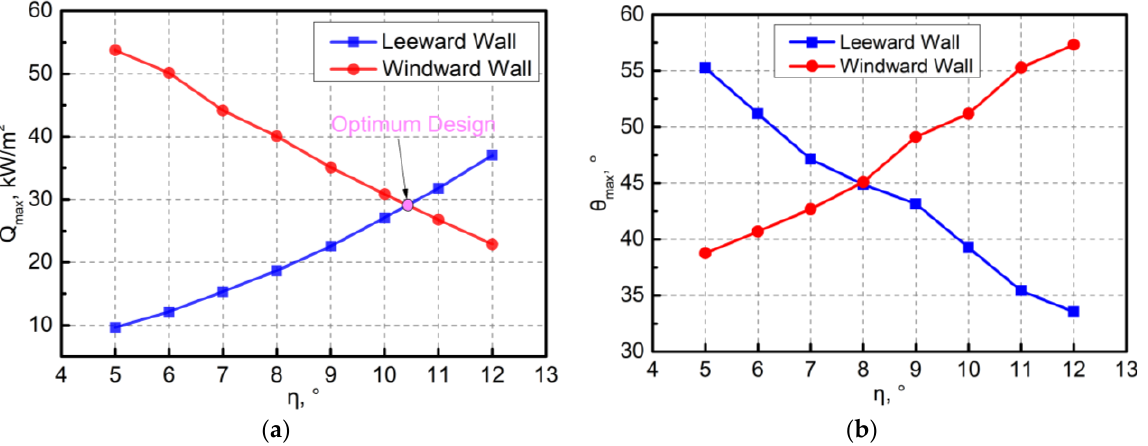
Figure 11. Peak heat flux and corresponding position at different installation angles: ( a ) peak heat flux; ( b ) position of peak heat flux.